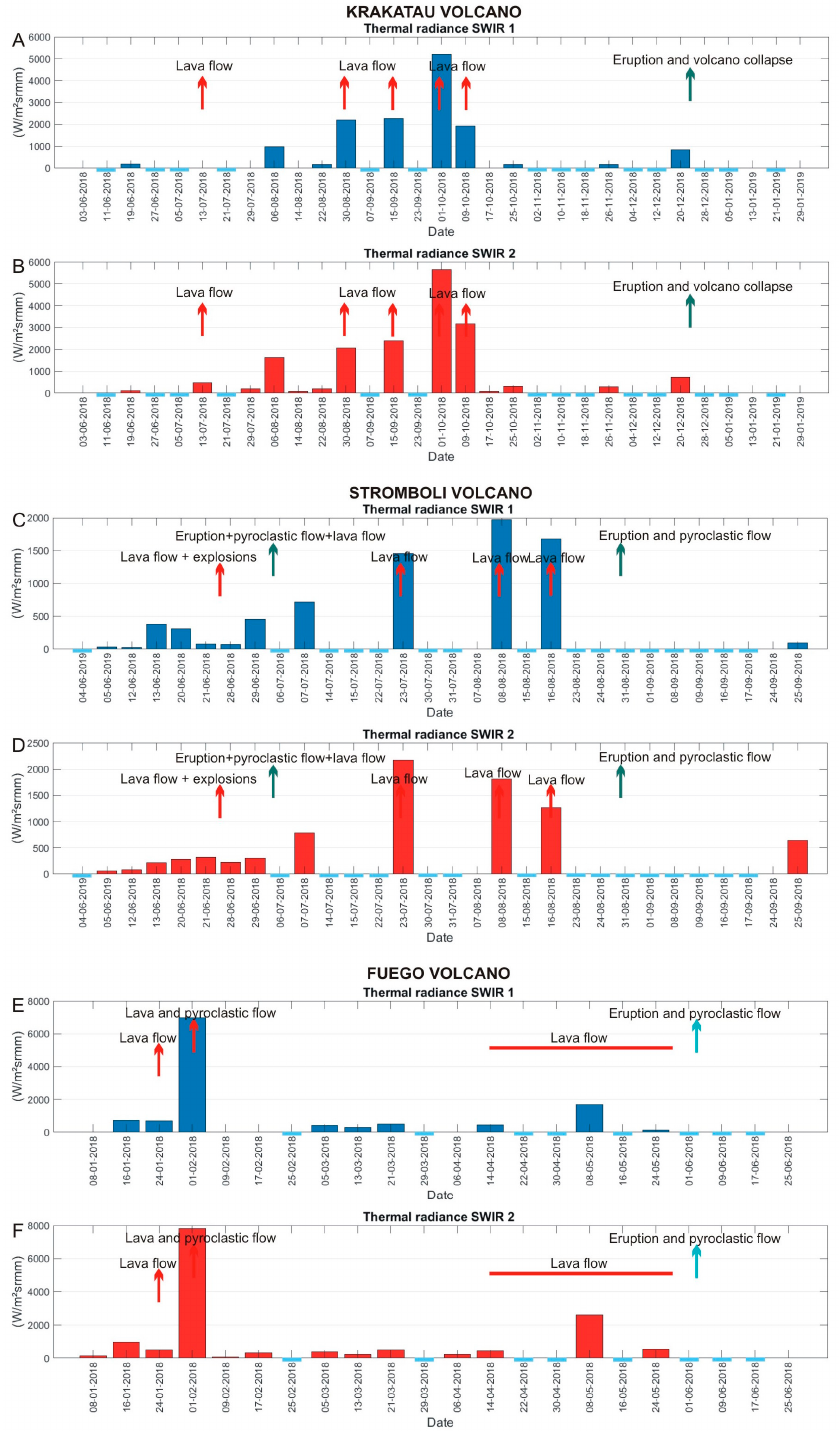
Figure 5. Thermal radiance vs. date graphics, showing the most relevant volcanic activity in Krakatau ( A , B ), Stromboli ( C , D ) and Fuego ( E , F ) volcanoes. Red and blue upward arrows show major eruptive activity as lava flows, pyroclastic flows, among others. Red horizontal bar shows a long period of lava flows emission. Light blue horizontal bars show dates where images were covered by clouds. Zero values correspond to absence of thermal anomaly.